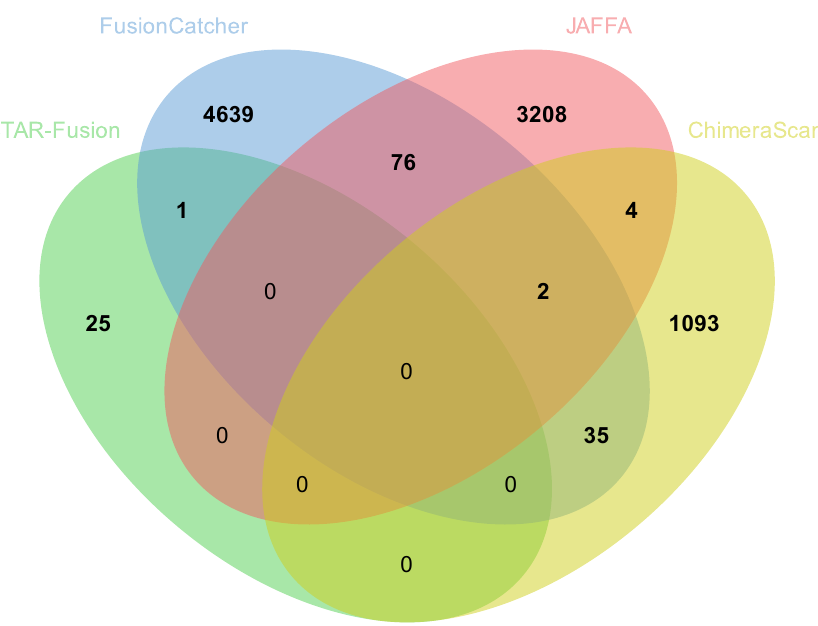
Figure 2. Comparison of fusion genes predicted by the different pipelines in African American patients. Total nonredundant fusions = 9203.